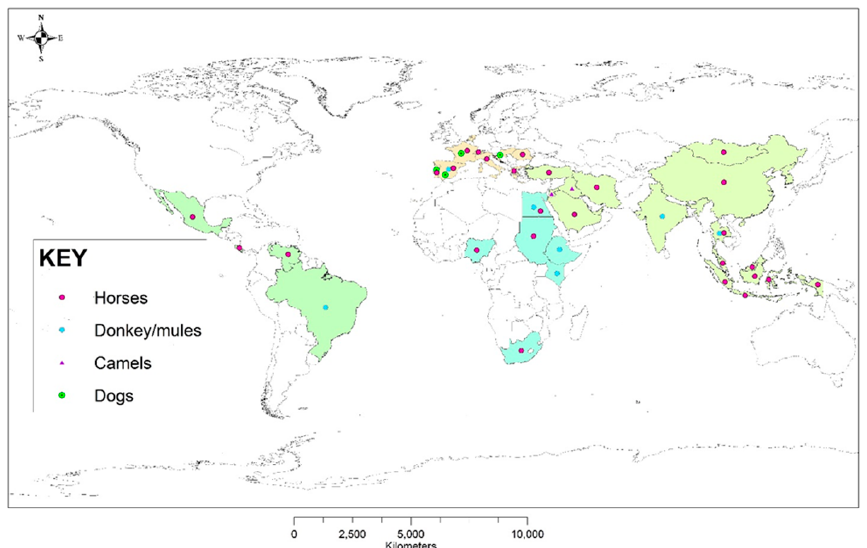
Figure 1. Worldwide distribution of regions where equine piroplasms have been detected or reported across different hosts in the last ten years (2008–2018).